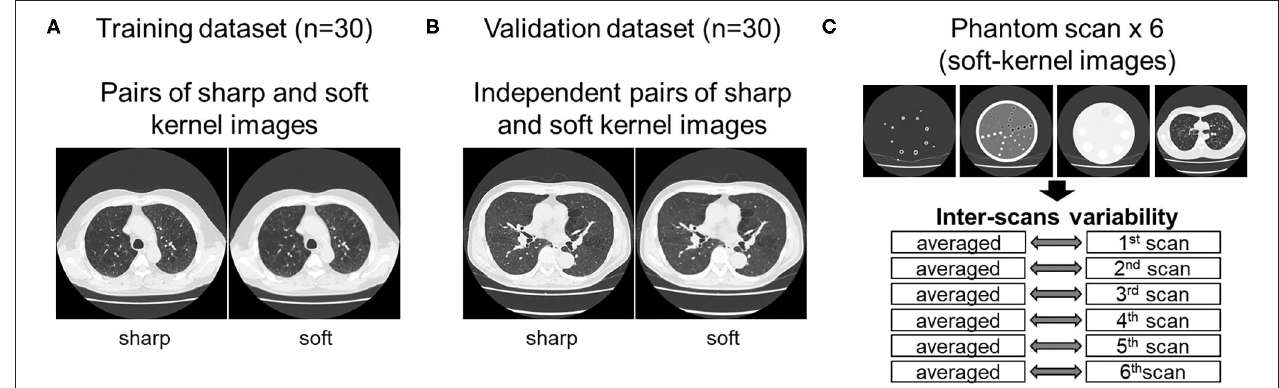
FIGURE 1 | Datasets used to establish and validate image conversion. (A) The training dataset comprised pairs of sharp and soft reconstruction kernel images from 30 smokers. The validation of deep learning-based conversion was performed using independent pairs of sharp and soft reconstruction kernel images from 30